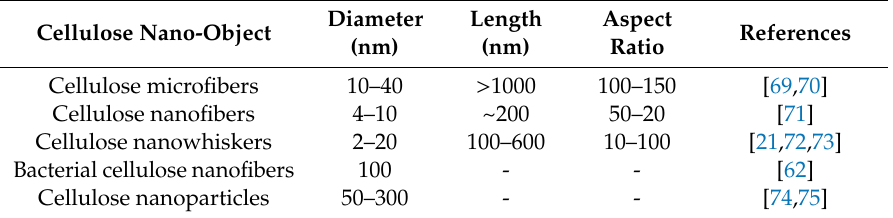
Table 2. Diameter, length, and aspect ratio of the di ff erent cellulose